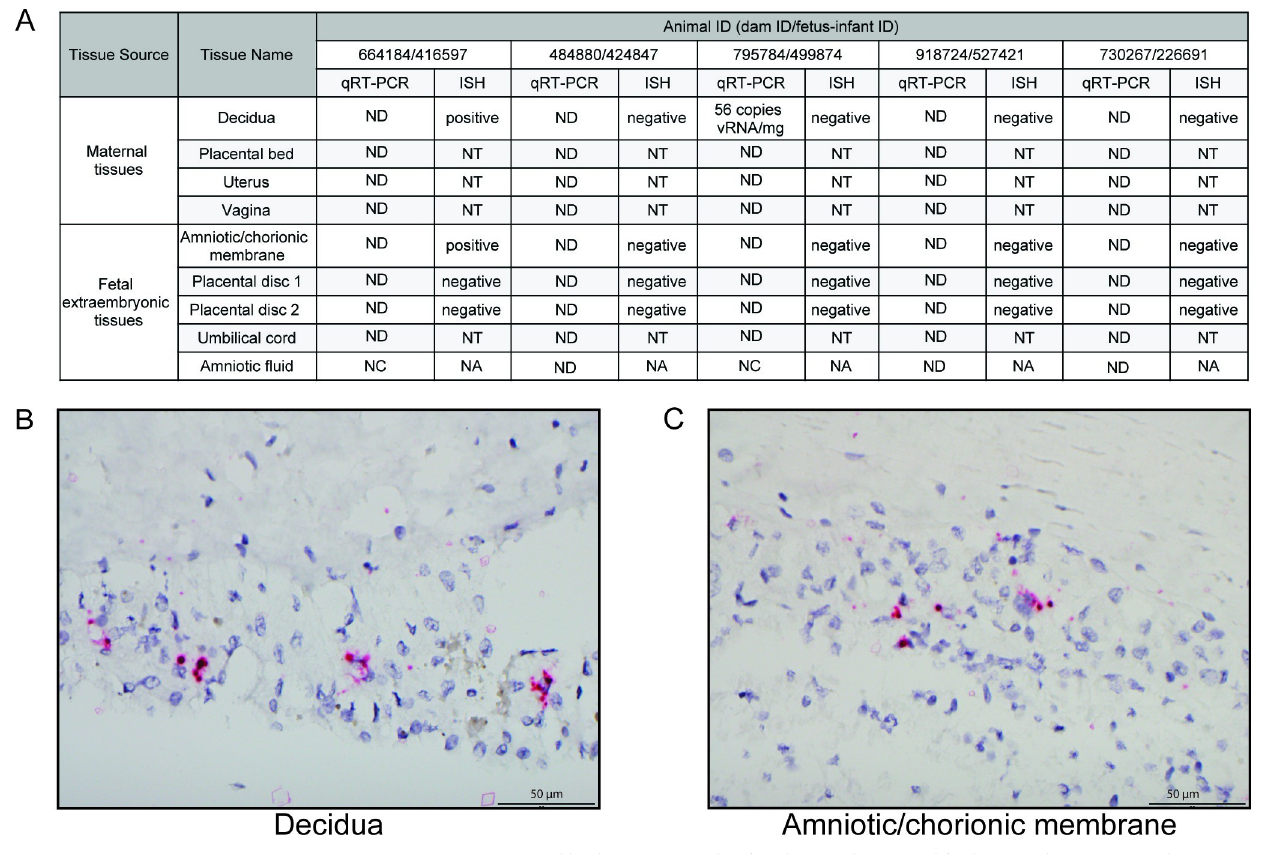
Fig 5. Viral loads and ISH in the maternal-fetal interface. (A) Viral loads were assessed in female reproductive and fetal extraembryonic tissues by qRT-PCR at delivery and sections of some of these tissues were assessed by ISH. (B) Positive ZIKV ISH in the decidua of dam 664184. (C) Positive ISH staining in the amniotic/chorionic membrane of fetus 416597. ND = not detected (below the limit of detection), NT = not tested, NC = not collected, NA = not applicable.